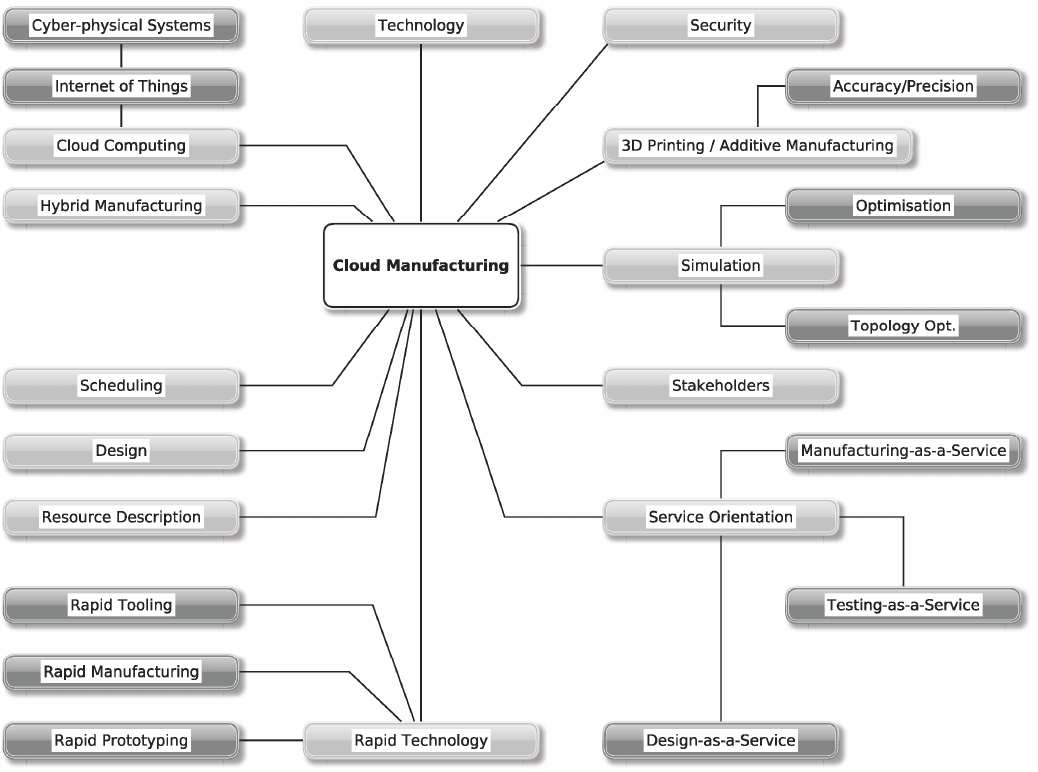
Figure 2. A flowchart of cloud manufacturing and the involved sections [17].